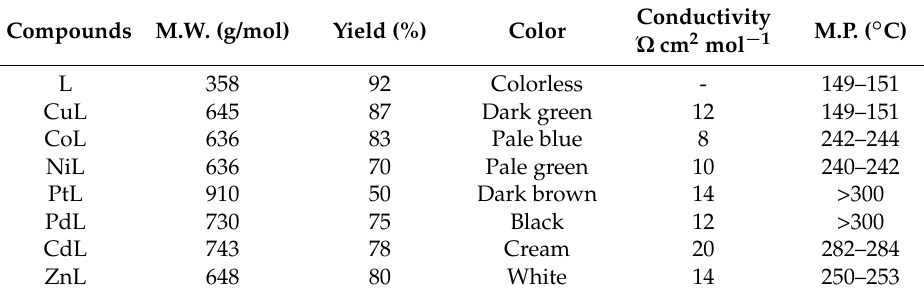
Table 2. Physical properties of Ligand (L) and its metal complexes.